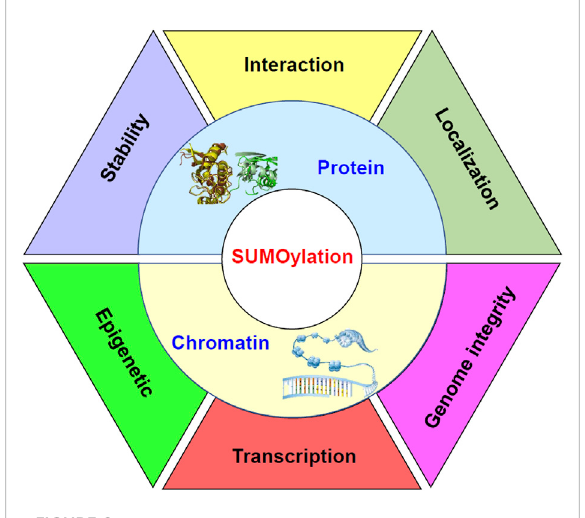
Diagram to demonstrate the molecular processes under the control of sumoylation in stem cells. Sumoylation regulates the stability, interaction, and localization of proteins. Meanwhile, sumoylationat chromatinmay function as epigeneticsignals. Sumoylation of transcription factors may affect the formation of the transcriptional machinery on the chromatin and regulate transcription of target genes. Furthermore, sumoylation of chromatin components may be important for the integrity of the